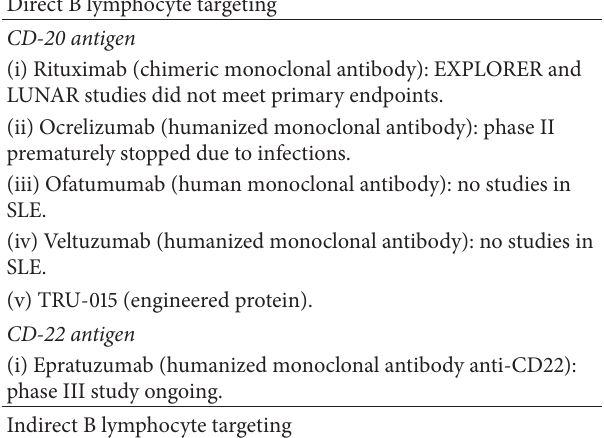
Table 3: Potential targets in B lymphocytes and the therapeutic molecule for the treatment of systemic lupus